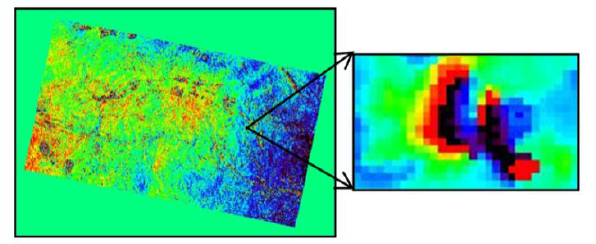
Figure 1. Filtered Interferogram and Subsidence fringe before atmospheric phase delay correction